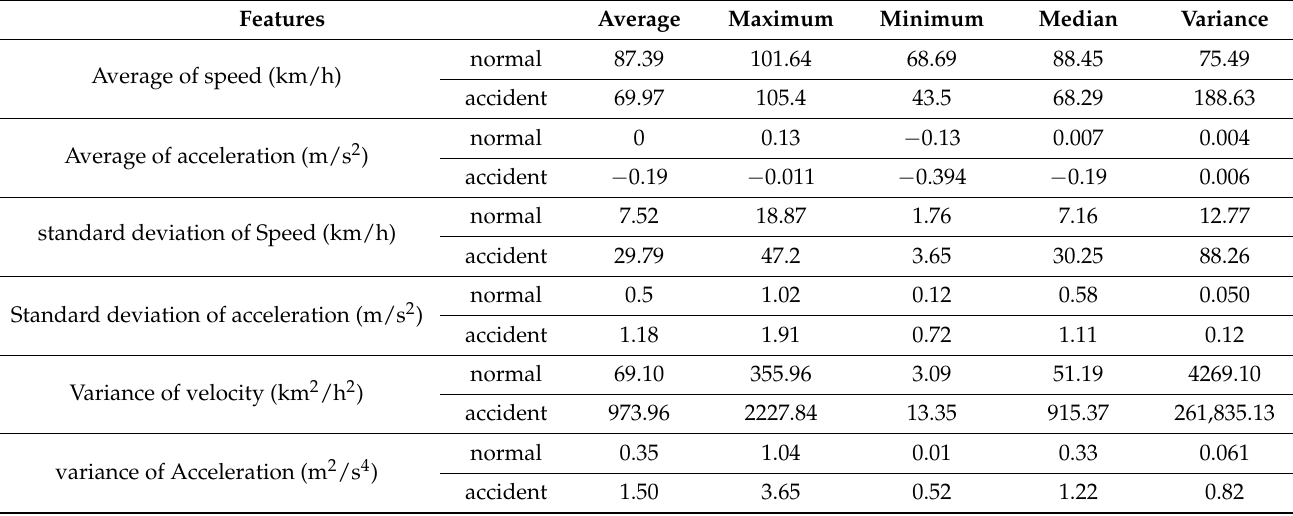
Table 4. Description of the original samples under various statistical